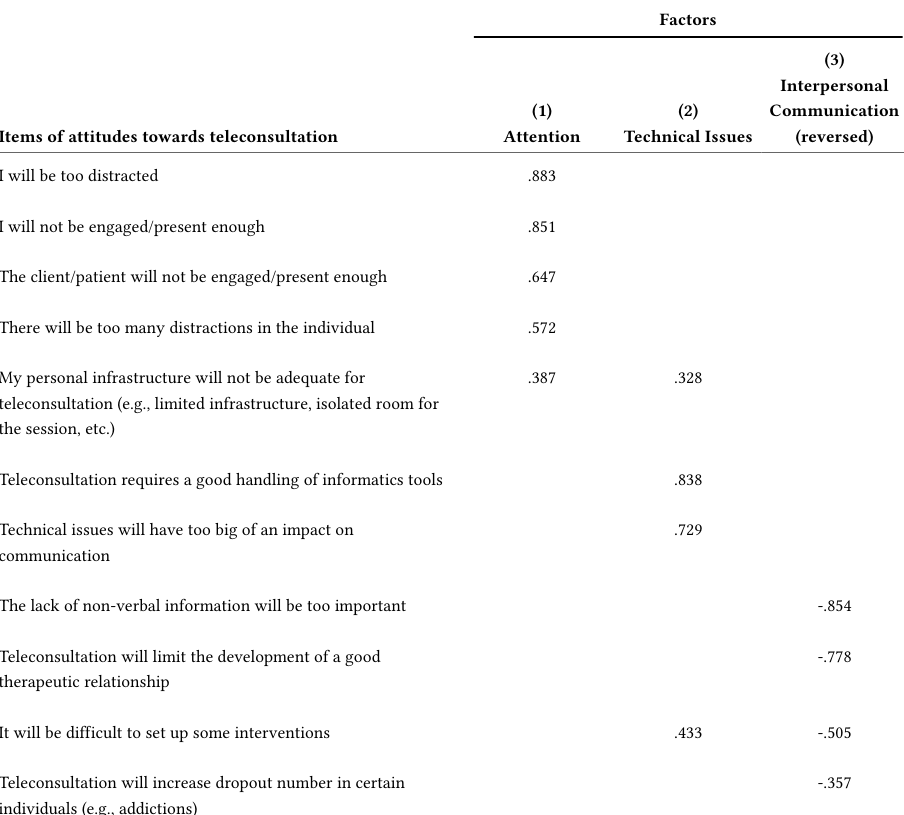
Factor Loadings, After Oblimin Rotation, for the 11 Items of Attitudes Towards Teleconsultation